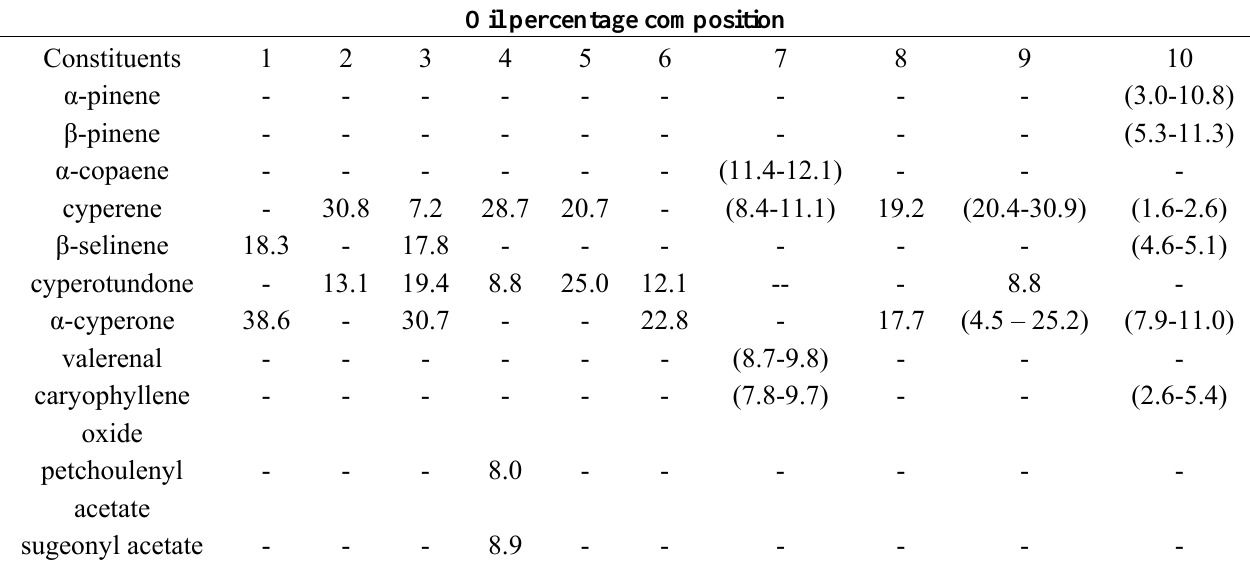
Table 2. Comparison of major constituents of C. rotundus rhizomes oils from different